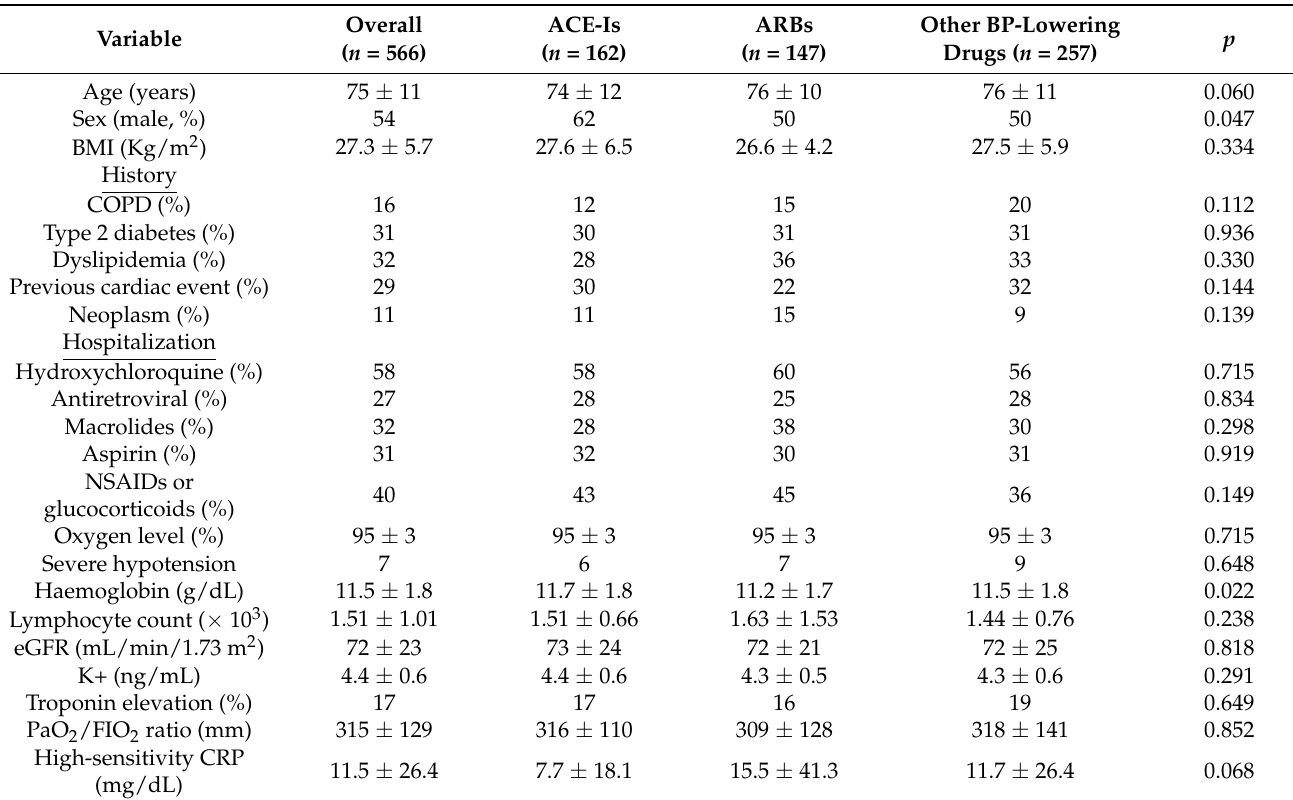
Table 1. Main characteristics of patients included in the